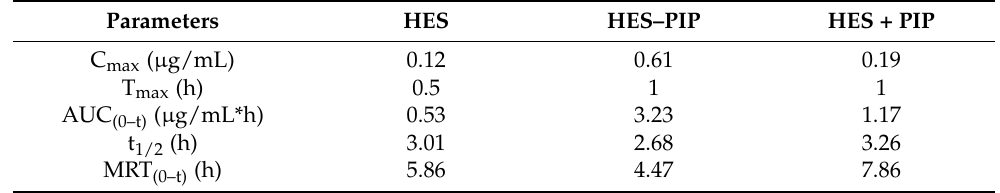
Table 3. Main pharmacokinetic parameters of free HES, HES–PIP cocrystal, and HES + PIP (physical mixture) in vivo ( n =